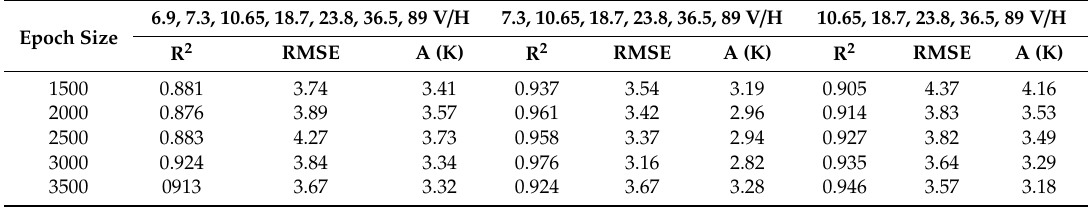
Table 2. Errors under di ff erent channel combinations.